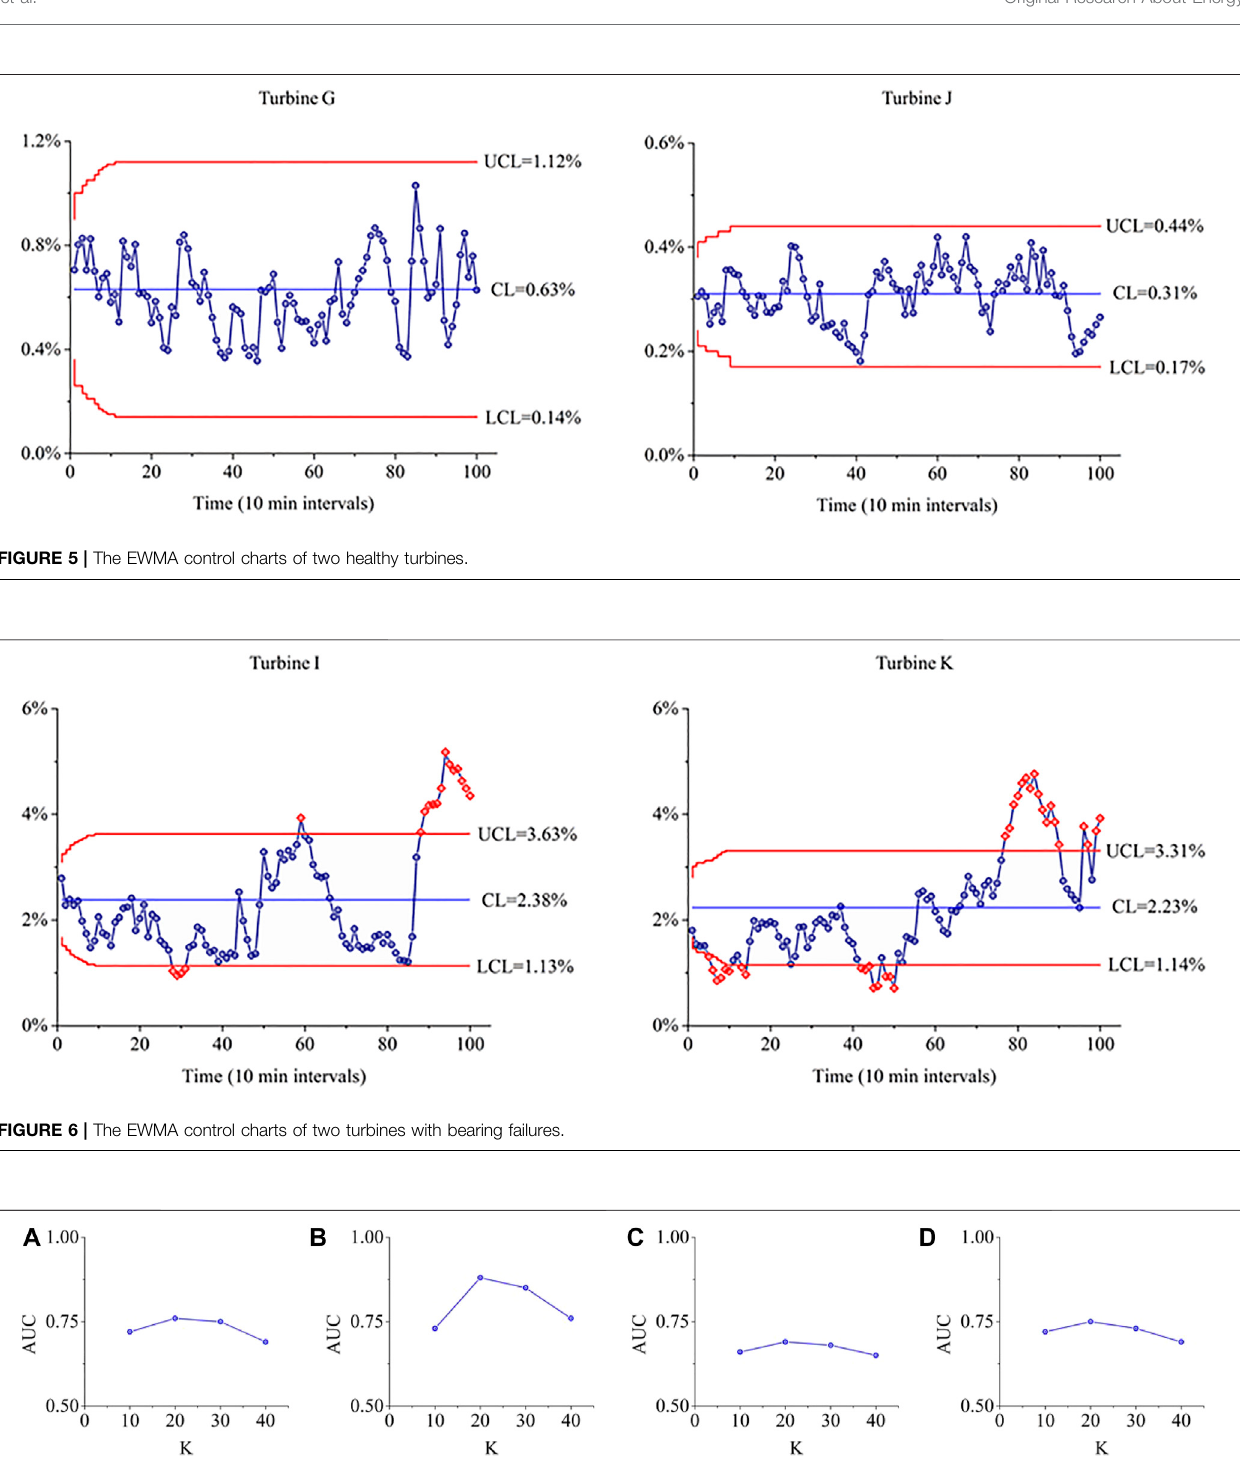
2.7 are tested and the computational results are illustrated in Figure 7 below. The AUC is selected as the measurement It is obvious that all algorithms reached their peak classi fi cation